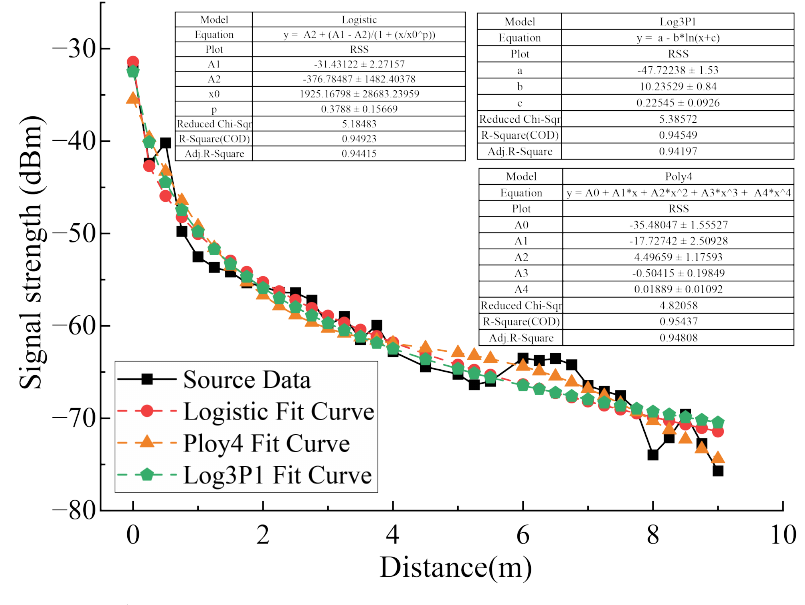
Figure 4. The RSS